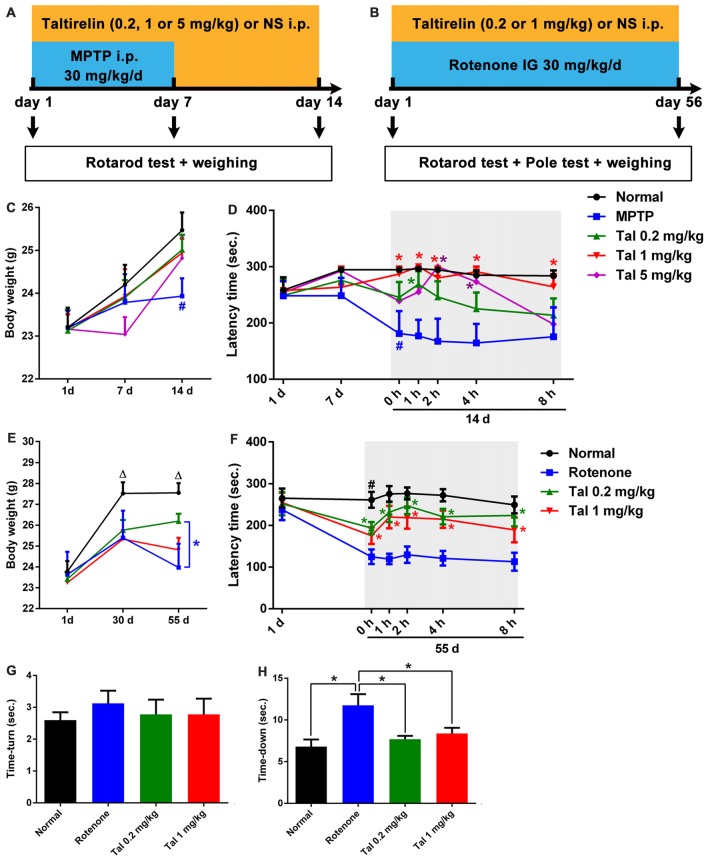
Taltirelin protected locomotor functions of Parkinson’s disease (PD) model mice. Schematic representation of the subacute MPTP-induced (A) and the chronic rotenone-induced (B) PD mice model experimental design. (C) Weight measurements on the first, 7th and 14th day of mice with MPTP (30 mg/kg, i.p.), with or without Taltirelin (Tal 0.2, 1 and 5 mg/kg). (D) Rotarod tests on the first, 7th and 14th day of MPTP modeling. (E) Weight measurements on the first, 30th and 55th day of mice with rotenone (30 mg/kg, IG), with or without Taltirelin (0.2 and 1 mg/kg). (F) Rotarod tests on the first and 55th day of rotenone modeling. (G,H) Pole tests on the 55th day of rotenone modeling. #p < 0.05 vs. normal; *p < 0.05; △p < 0.05 vs. other groups. N = 4. Error bars represent SEM.